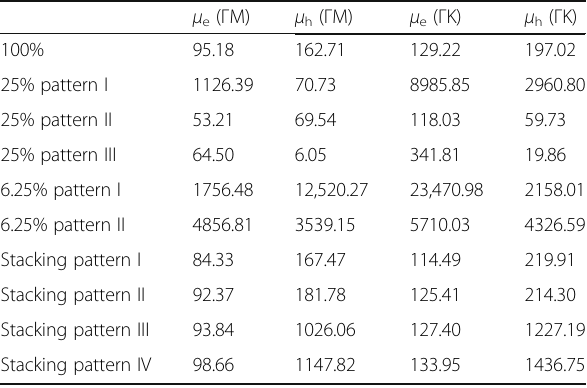
Table 2 The electron and hole mobilities in Γ M and Γ K direction. The subscripts “ e ” and “ h ” refer to electron and hole,